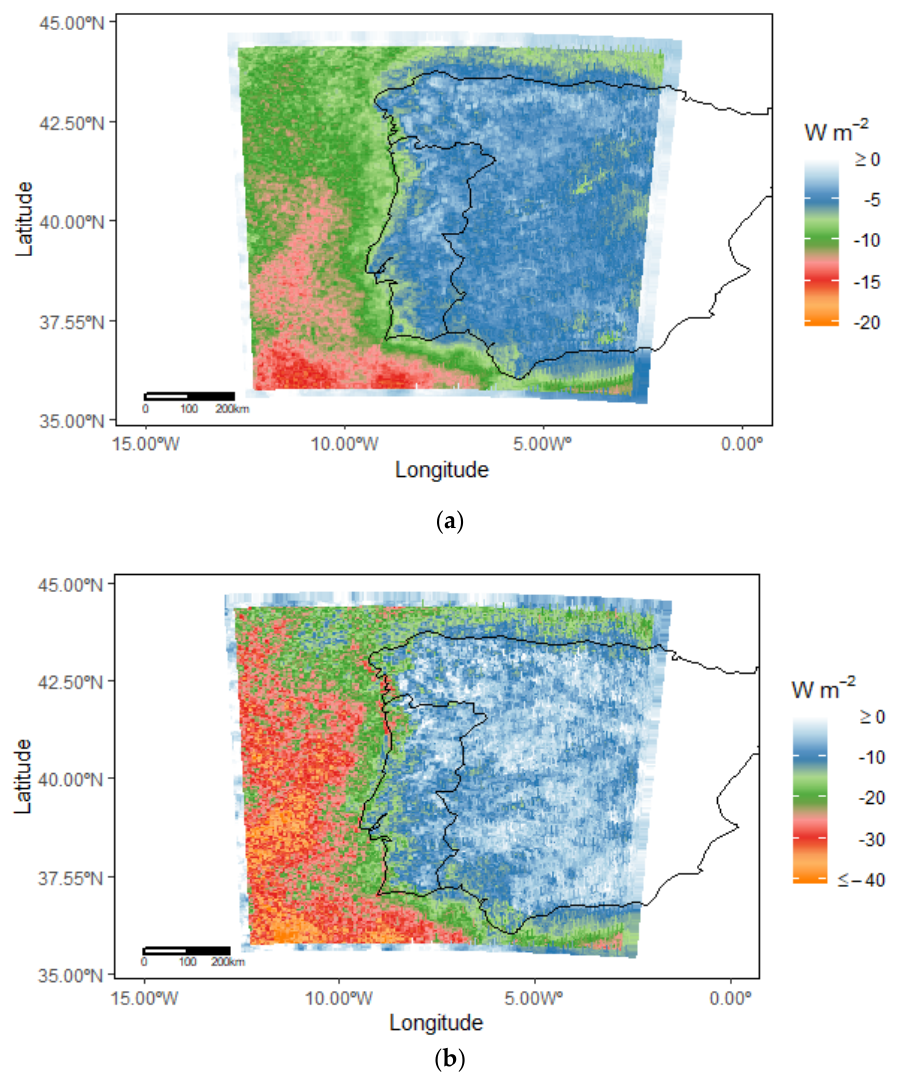
Figure 6. Spatial differences of solar radiation comparing both simulations (with feedback and without feedback): ( a ) annual average including all hourly values; and ( b ) annual average of daily maximum values.